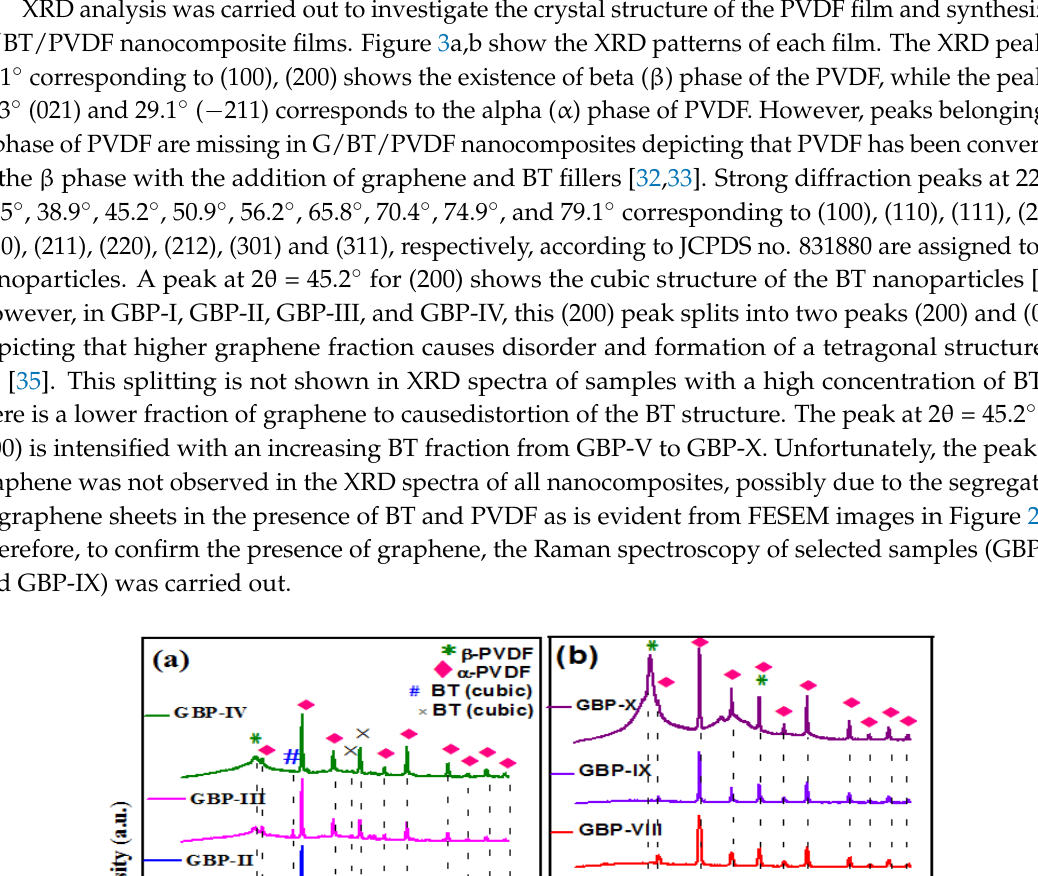
Figure 2. Field emission scanning electron microscopy (FESEM) images of ( a ) G/BT/PVDF nanocomposite films with different graphene fraction and ( b ) G/BT/PVDF nanocomposite films with